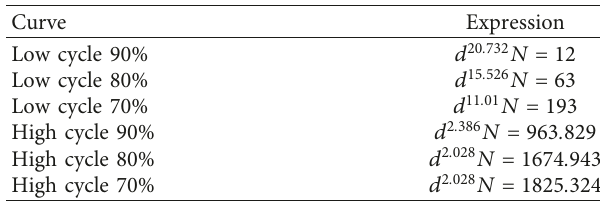
Table 5: Summary of line expressions of the loosening D-N curve.